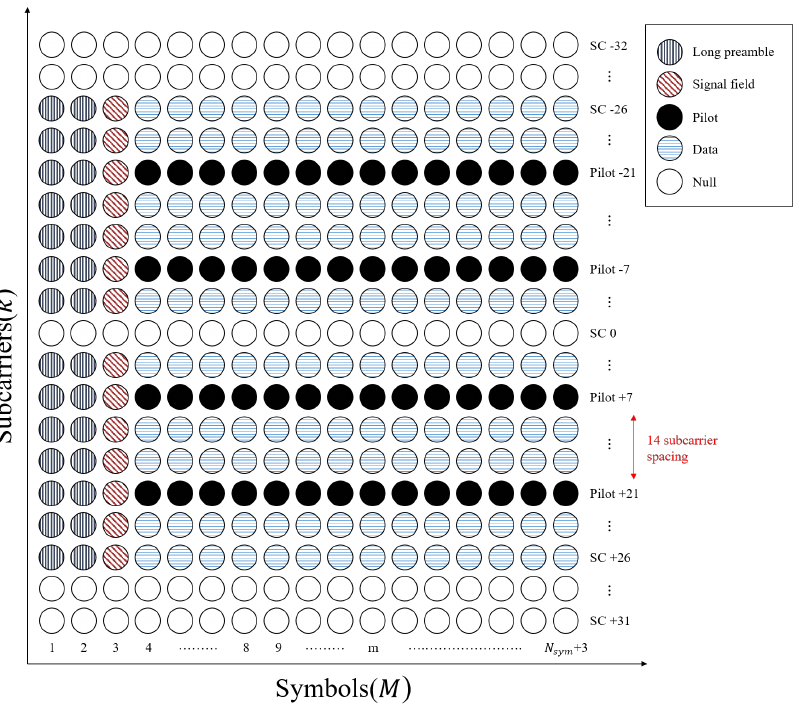
Figure 2. Preamble, signal field, pilot and data arrangement map for IEEE 802.11p [18,19]. Note that data and pilot started to fill in for transmission after third